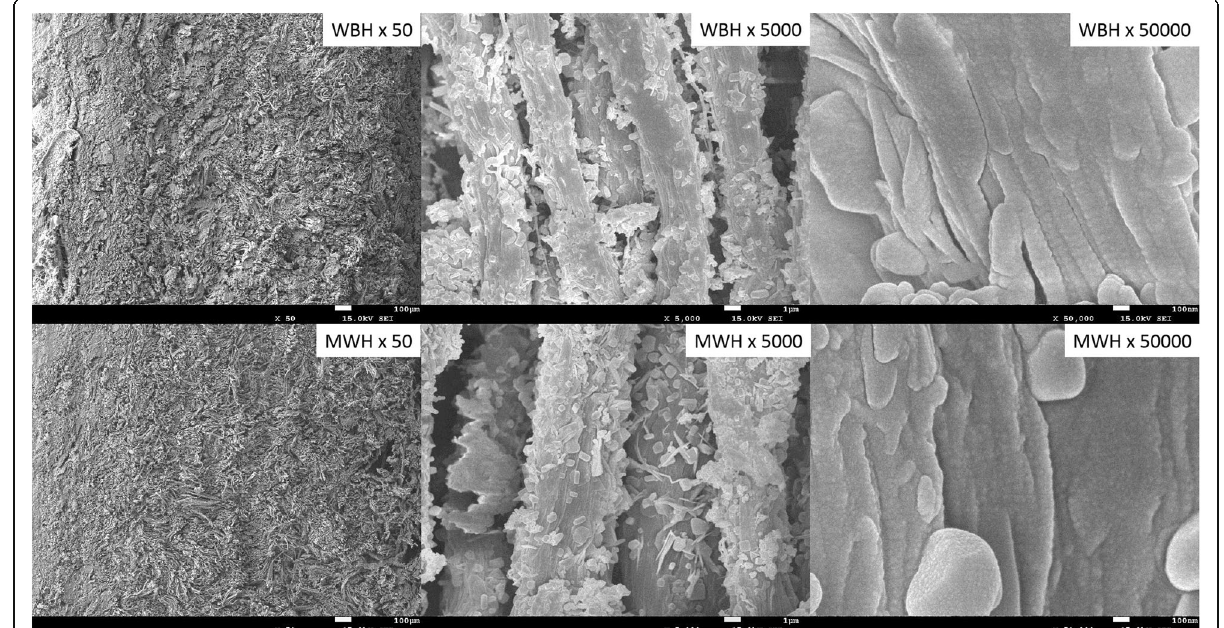
Fig. 7 SEM images of aluminum tanned skin pieces under different heating